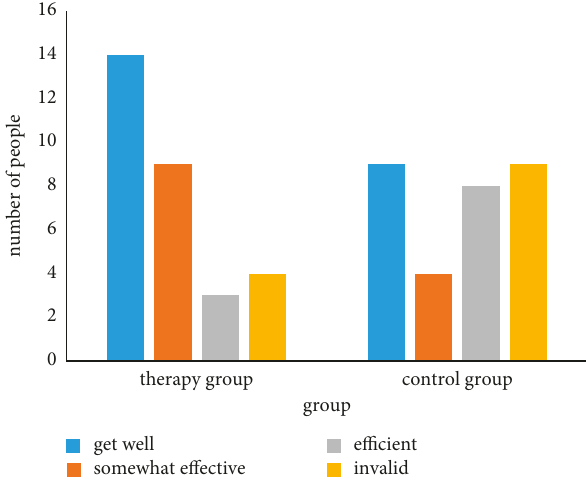
Figure 5: Histogram one and a half years after